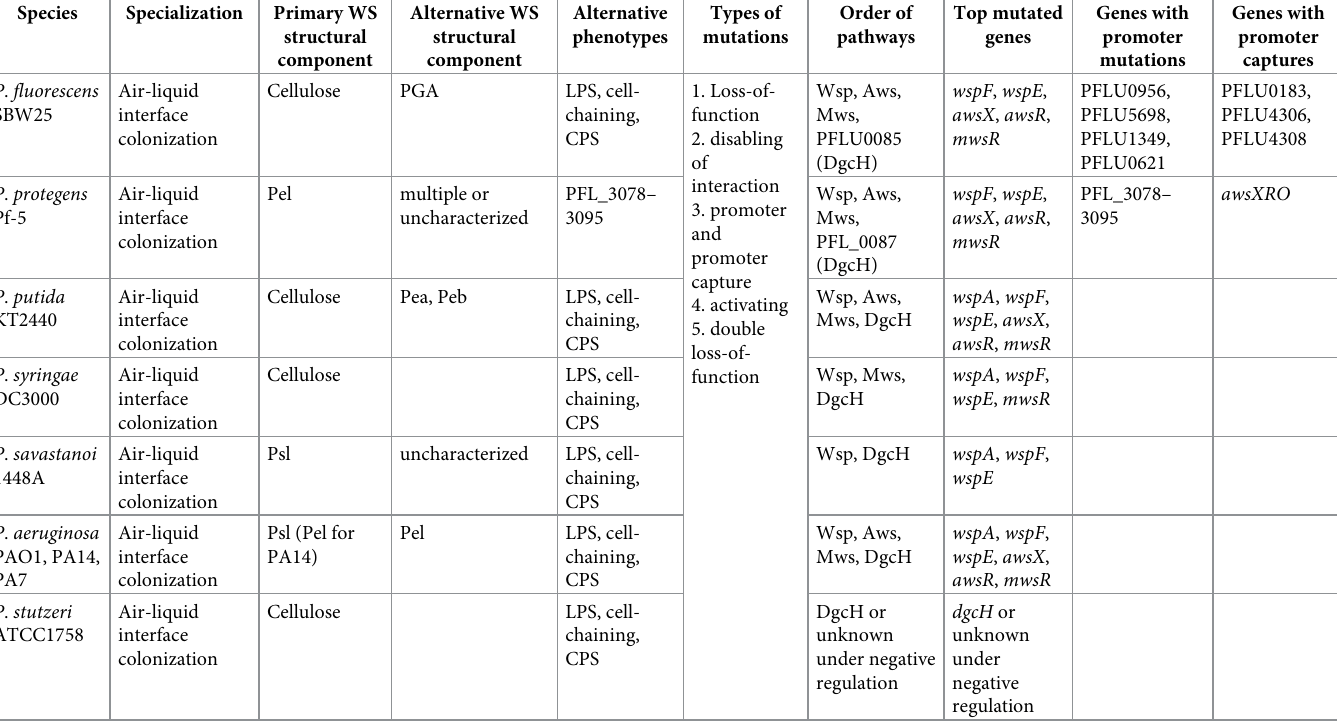
Table 1. Predictions for other Pseudomonas